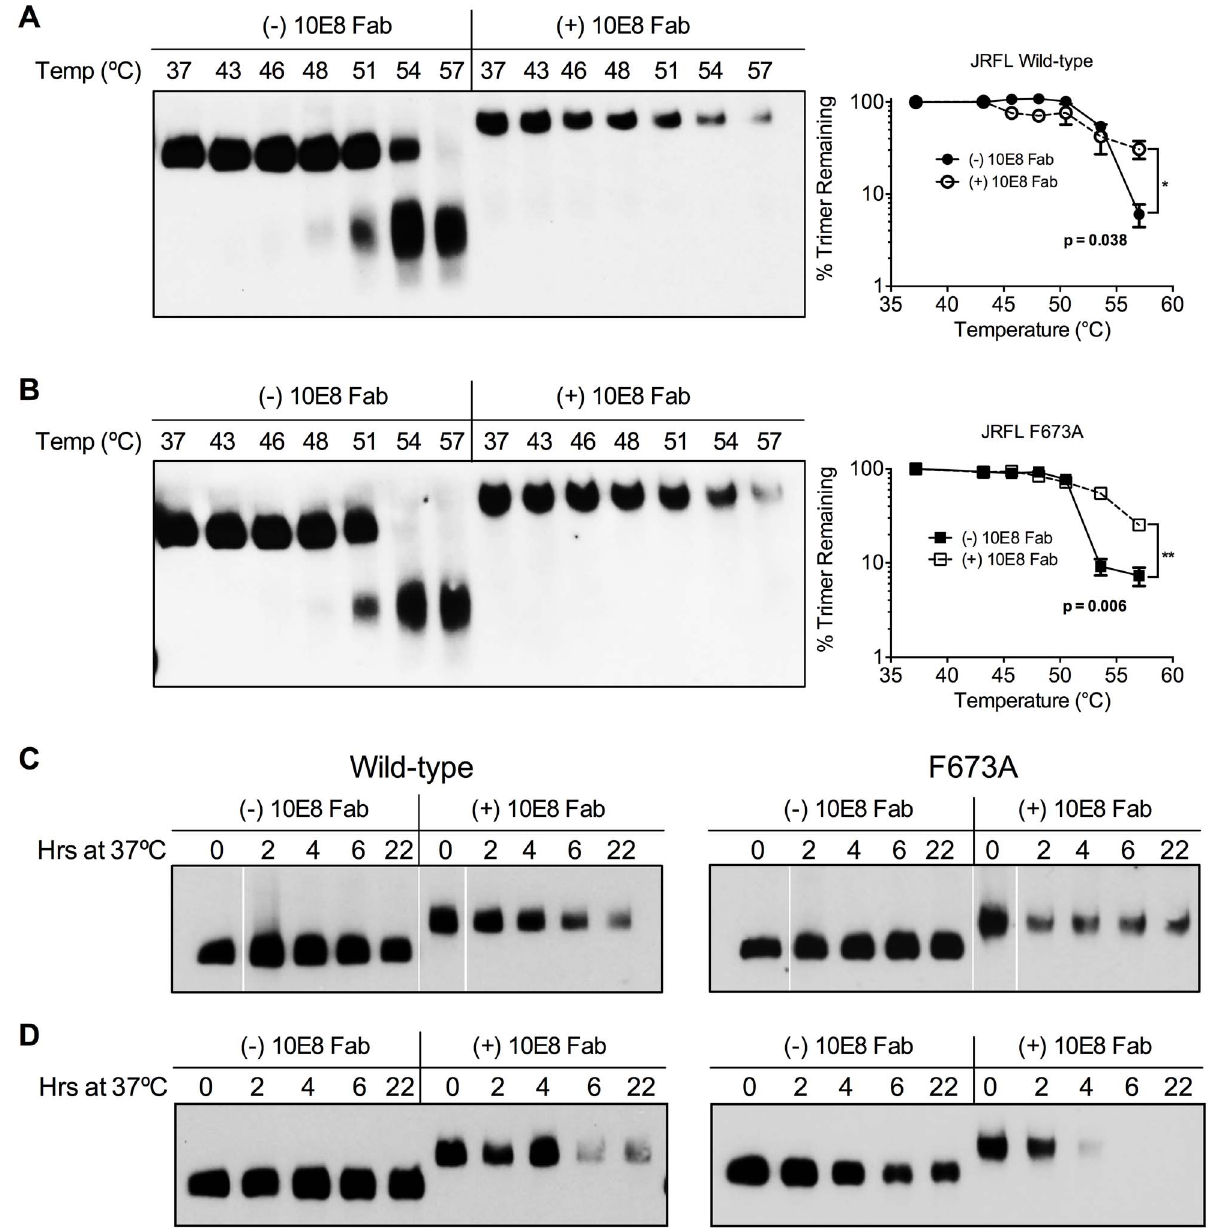
Figure 10. 10E8 enhances physical stability of Env trimers against heat-induced denaturation. JR-FL ( A ) wild type and ( B ) F673A mutant virions were exposed to increasing temperatures in the absence (leftmost lanes) or presence of 100 m g/ml 10E8 Fab (rightmost lanes). Following detergent solubilization, the oligomeric state of Env was determined using BN-PAGE and Western blot probed with anti-gp41 antibodies. The intensity of the Env trimer bands from each lane were quantified and plotted as the percentage of trimer remaining relative to that incubated at 37 u C (far right). ( C ) JR-FL wild type or F673A virions or ( D ) detergent-solubilized Env was incubated in the presence or absence of 10E8 Fab over a time course at 37 u C, and the oligomeric state of Env was analyzed using BN-PAGE Western